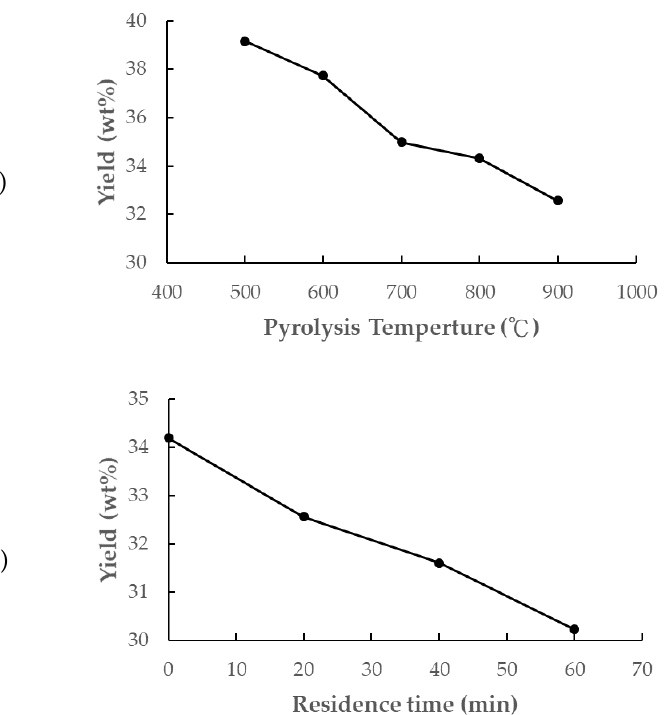
Figure 1. TGA and DTG of pineapple peel (PP) at temperature increases of 10 °C/min under a N 2 gas flow.